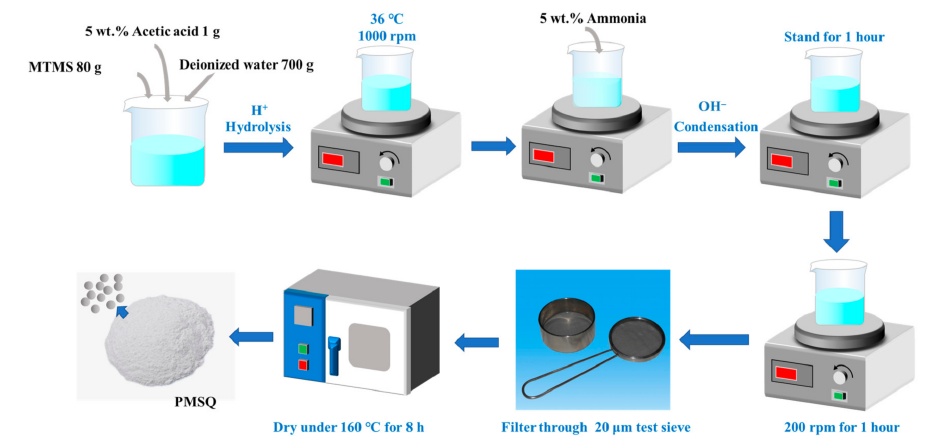
Figure 2. Basic synthesis procedure of the PMSQ